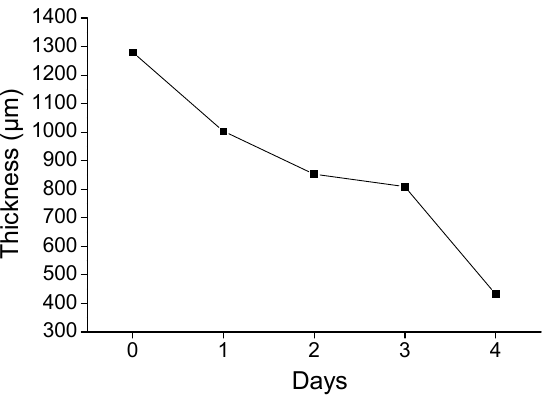
Figure 6. The evolution of thickness coating throughout the HHD spraying test.